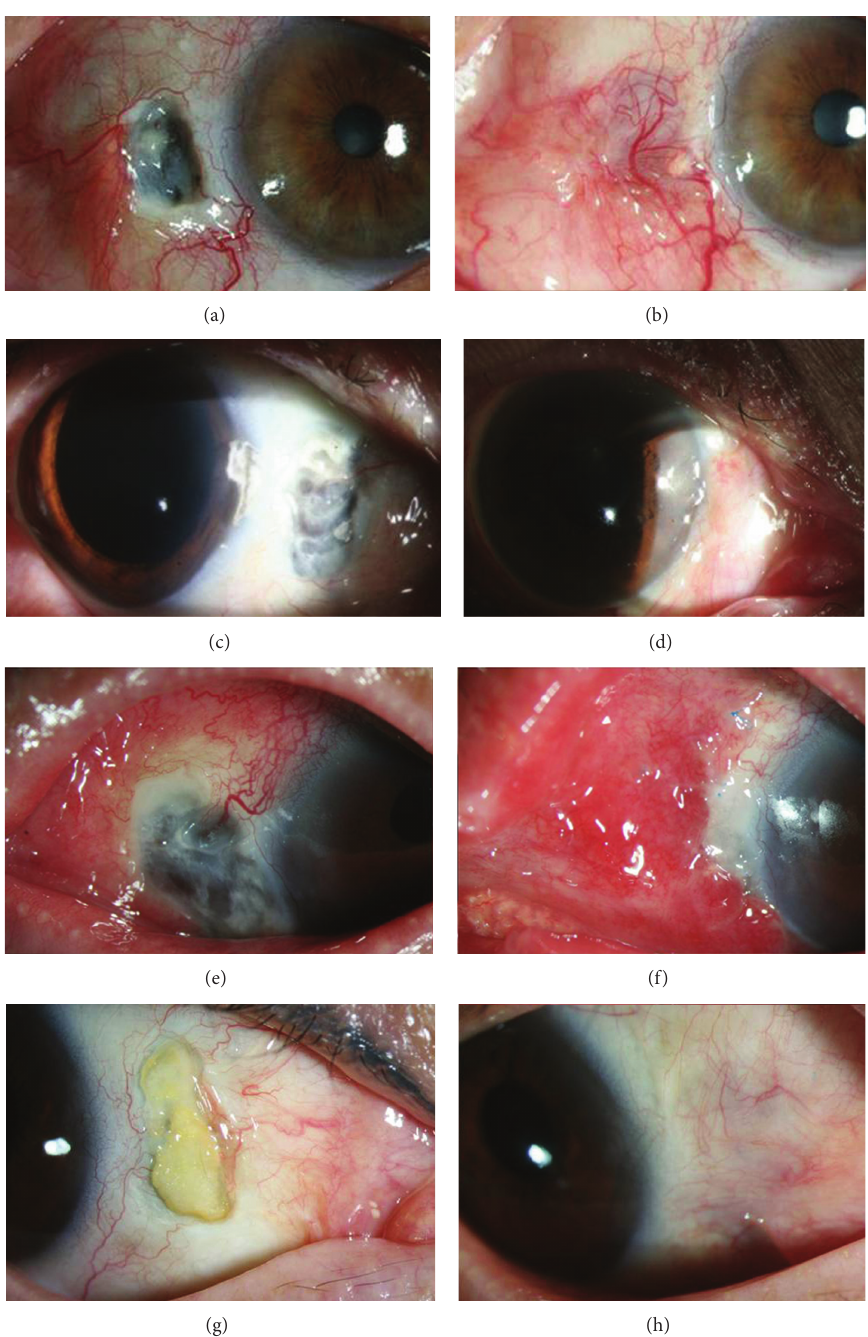
Figure 2: Case 1: (a) preoperative photograph, a 2.9 × 5.3 mm sized scleral thinning with visible uvea. (b) Successful reconstruction of ocular surface at 2 months after surgery. Case 2: (c) preoperative photograph, a 3.8 × 6.3 mm sized scleral melt with visible choroid. (d) Postoperative successful reconstruction of ocular integrity at 10 months after surgery. Case 3: (e) preoperative photograph, a 4.8 × 6.8mm sized scleral thinning with uveal exposure. (f) Successful tenon tissue graft and conjunctival flap without complications at postoperative 4 weeks. Case 4: (g) preoperative photograph, a 2.1 × 5.5 mm sized scleral thinning with large calcified plaque. (h) Successful reconstruction of ocular surface at 12 months after tenon graft combined with conjunctival